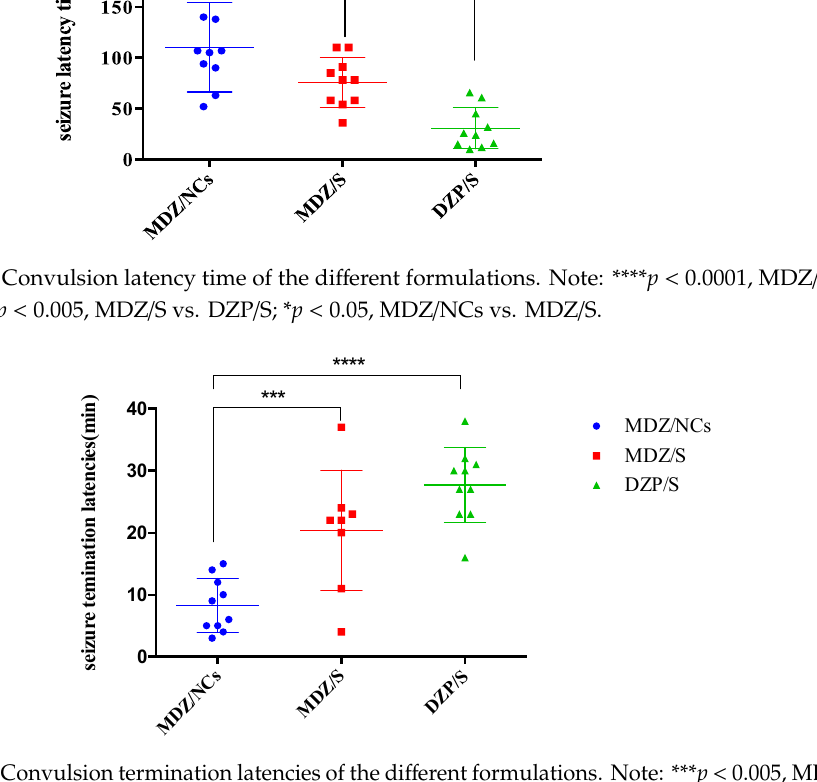
Figure 11. Convulsion termination latencies of the different formulations. Note: *** p < 0.005, MDZ/NCs vs. MDZ/S; **** p < 0.0001 MDZ/NCs vs. DZP/S; p > 0.05, MDZ/S vs. DZP/S .